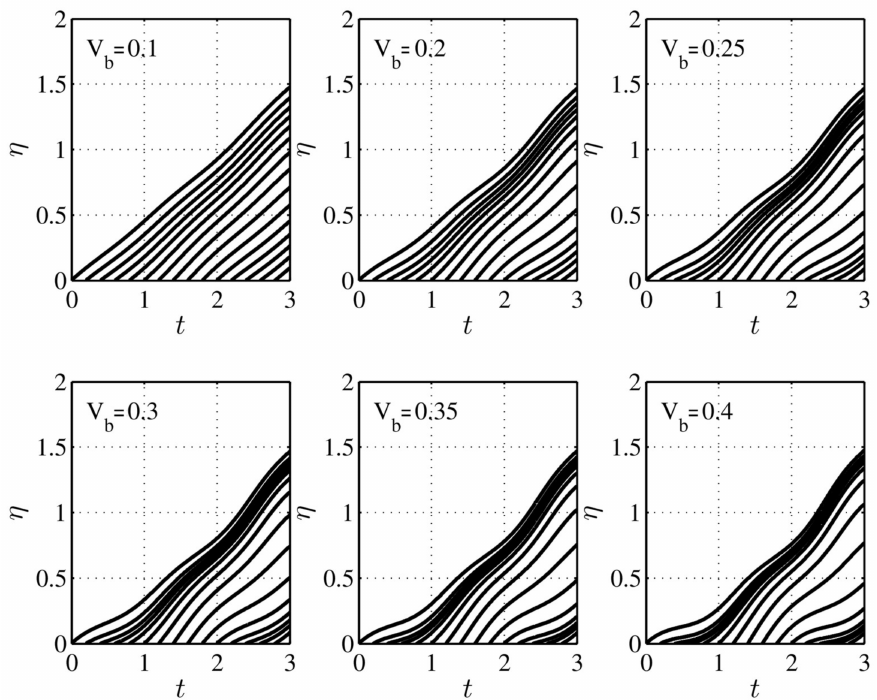
Figure 3. Influence of amplitude of the standing wave, V b , on characteristic curves for spray droplet dynamics in a host gas standing wave